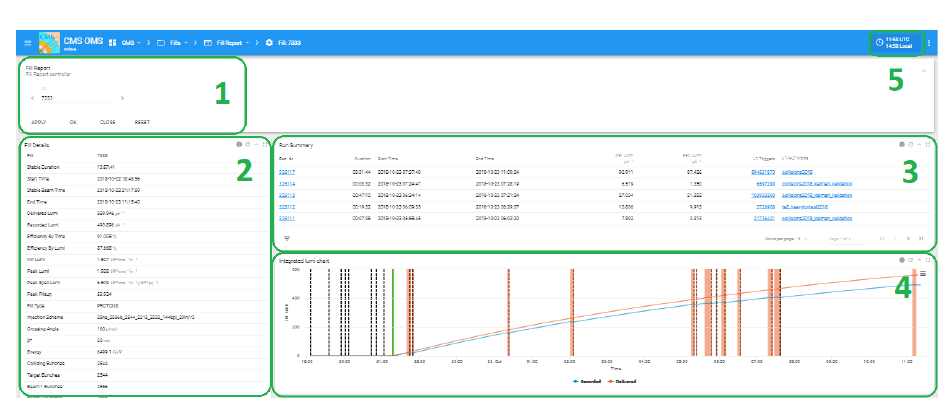
Figure 2. Fill Report page is made up of the open controller (1), vertical Data table (2), horizontal Data table (3), dynamic Chart (4), UTC and local time (5)